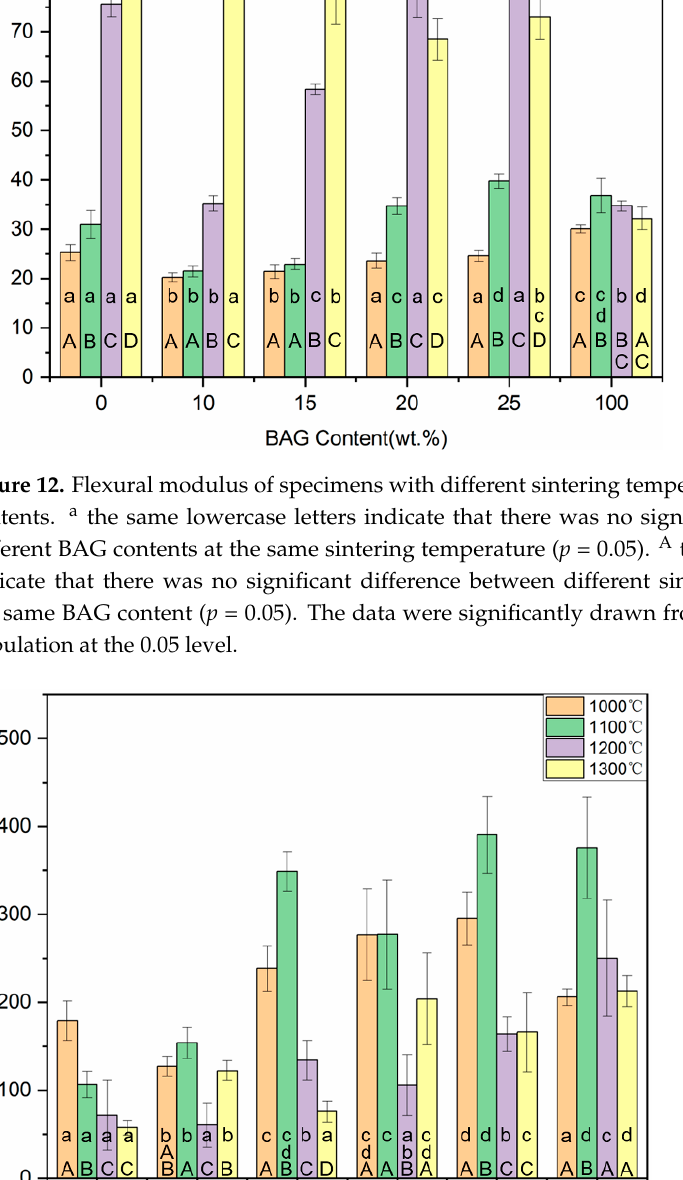
Figure 13. Compressive strength of specimens with different sintering temperatures and different BAG contents. a the same lowercase letters indicate that there was no significant difference between different BAG contents at the same sintering temperature ( p = 0.05). A the same uppercase letters indicate that there was no significant difference between different sintering temperatures with the same BAG content ( p = 0.05). The data were significantly drawn from a normally distributed population at the 0.05